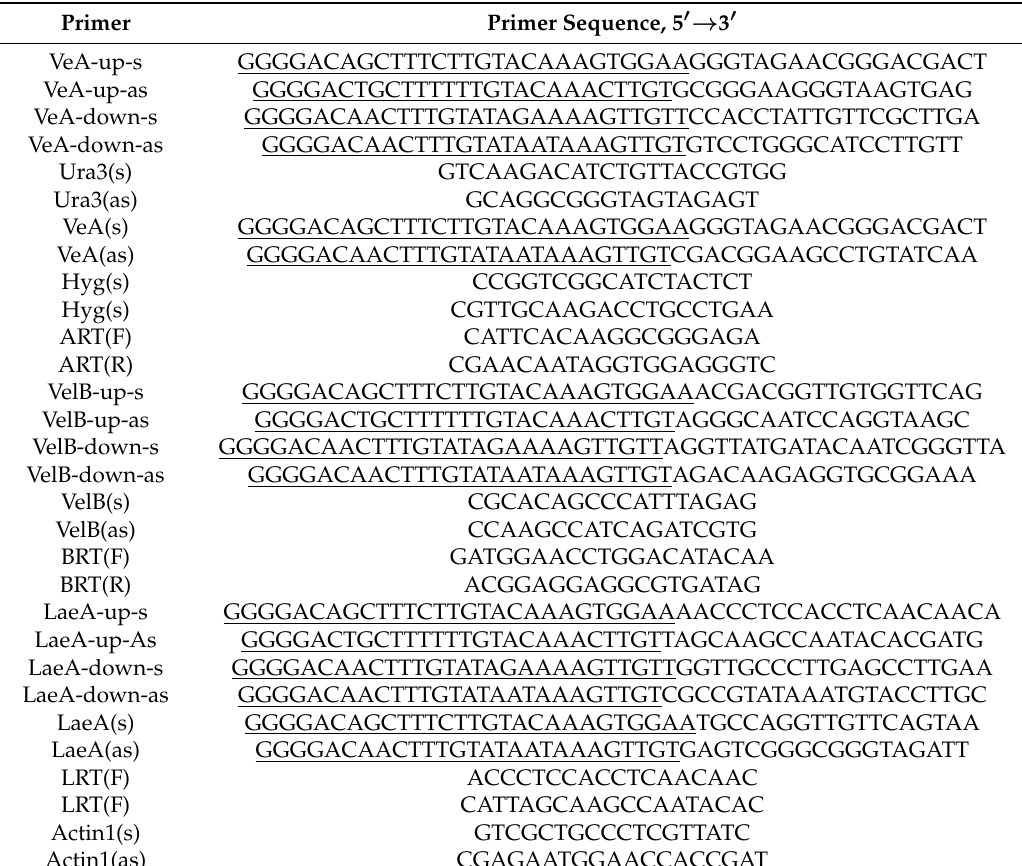
Table 1. Primers used in this study. Under lines indicate the attB sequence. Primer Primer Sequence, 5 (cid:48) → 3